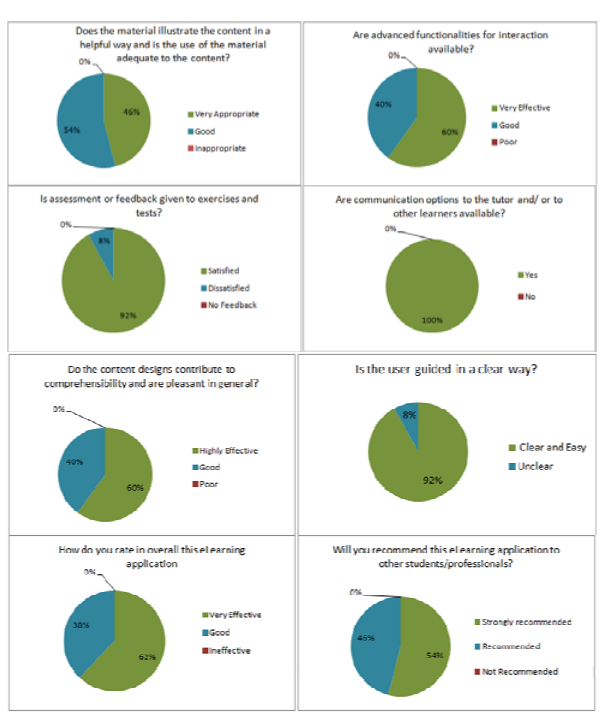
Figure 3: Feedback of 25 users for the Moodle